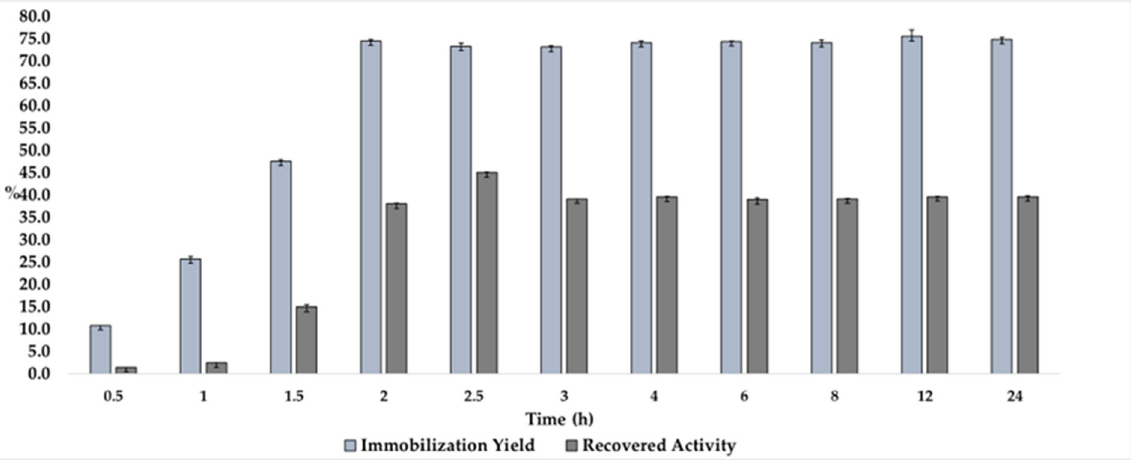
Figure 3. Effect of the time on immobilization yield and recovered activity in the immobilization of L Asp on CC support. Experimental conditions: 0.150 g of CC, 5 mL of laccase solution (0.1 g.mL − 1 ) in sodium phosphate buffer solution at pH 7.0 (0.1 M), and 4 °C at 100 rpm under a shaker.